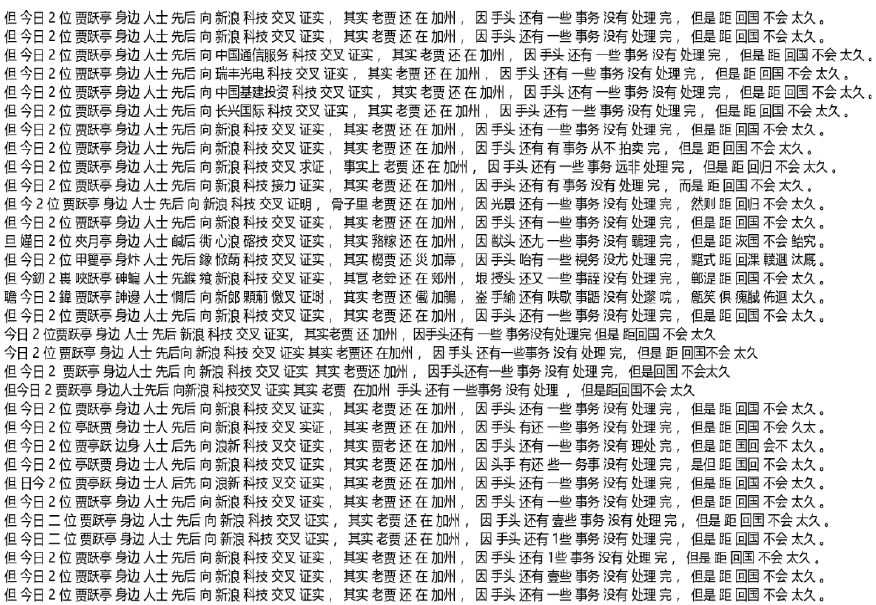
Figure 2. Effect diagram of sample after data enhancement. (Example in the figure: Today, two people around Jia Yueting successively confirmed to Sina technology that Jia Yueting is still in California because there are still some things to deal with, but it will not be long before he returns home.).